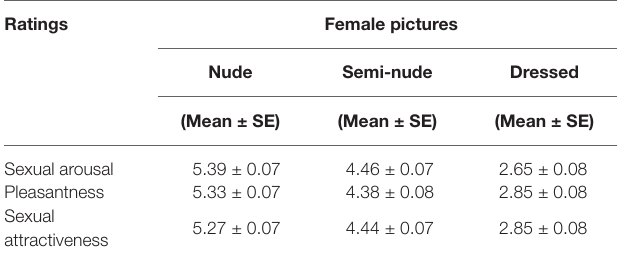
TABLE 2 | Males’ sexual arousal, pleasantness, and sexual attractiveness ratings for female